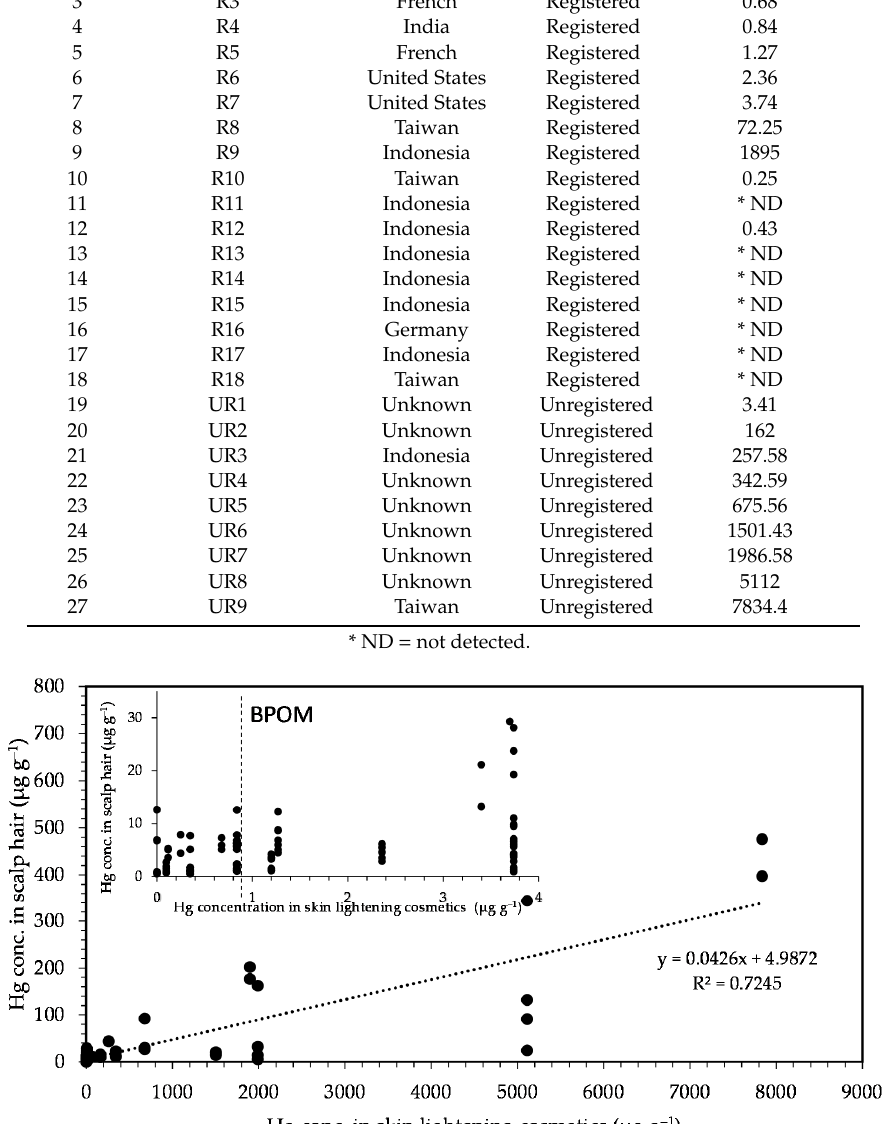
Figure 3. Correlation between Hg in hair and cosmetics in the students’ scalp hair and cosmetics for every group of cosmetic consumptions. 4.2. Student Health Issues Neurological symptoms suffered by the students cannot be associated with inorganic Hg toxicity from the cosmetics because the students in the control group showed a similar amount of such symptoms. The health assessment recorded 9 of the 15 user-group students who were tested displaying symptoms: two students with three symptoms, two students with two symptoms and four students with one symptom. Whereas, in the control group, there were three students with one symptom, two students with two symptoms. Only irregular eye movement, and unbalanced rigidity & ataxia can be considered prevalent within the cosmetic-using students (< seven percent occurrences) because not any single student in the control group were suffered by those symptoms. However, potential health issues remain as inorganic Hg in cosmetics may also enter the body through inhalation [33] and ingestion [12], as in the case of inhalation in gold smelting where, after working for at least five years, tremors were detected in up to 85% of cases [16]. The topical application of Hg compounds in cosmetics may result in Hg being accumulated in the kidneys [34], with a case of nephrotic syndrome reported for a 34-year-old woman who used skin- 0.1 1 10